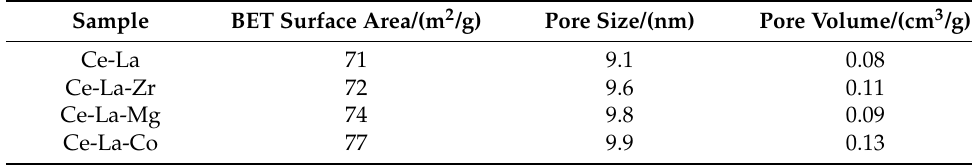
Figure 3. N 2 adsorption–desorption isotherms of metal elements doped cerium lanthanum solid solution. Table 2. Textural parameters of solid